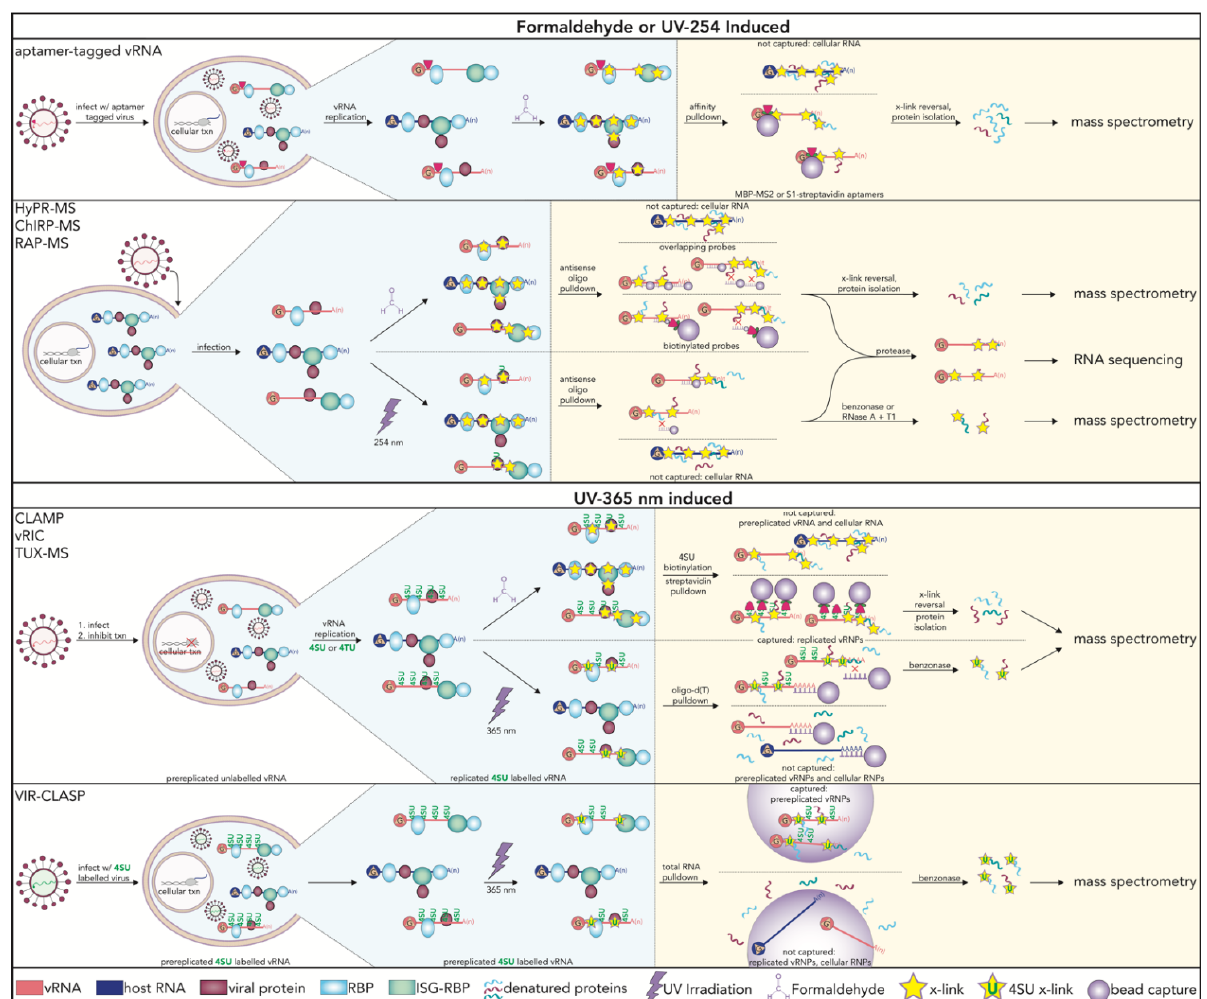
Figure 3. An overview of methods that interrogate vRNA-RBP interactions in live cells during viral infection. Methods to probe vRNA-RBP interactions are grouped based on overlapping methodologies. The blue shaded region denotes the cellular environment in which interactions are stabilized. The yellow shaded region shows how those interactions are captured. Also outlined in the yellow shaded region are interactions that are captured vs. those that are not. Notably, formaldehyde- based methods result in the crosslinking and capture of protein-protein interactions whereas 4-thiouridine (4SU) based methods (bottom two panels) have the highest level of stringency. vRNA: viral RNA; txn: transcription; x-link: crosslink; 4TU: 4-thiouracil; RBP: RNA binding protein; ISG: interferon stimulated gene; HyPR-MS: Hybridization Purification of RNA-protein complexes followed by Mass Spectrometry; RAP-MS: RNA Antisense Purification and quantitative Mass Spectrometry; ChIRP-MS: Comprehensive Identification of RNA binding Proteins by Mass Spectrometry; vRIC: vRNA Interactome Capture; CLAMP: Cross-Link-Assisted Messenger ribonucleoprotein Purification; TUX-MS: Thiouracil Cross- Linking Mass Spectrometry; VIR-CLASP: VIRal CrossLinking And Solid-phase